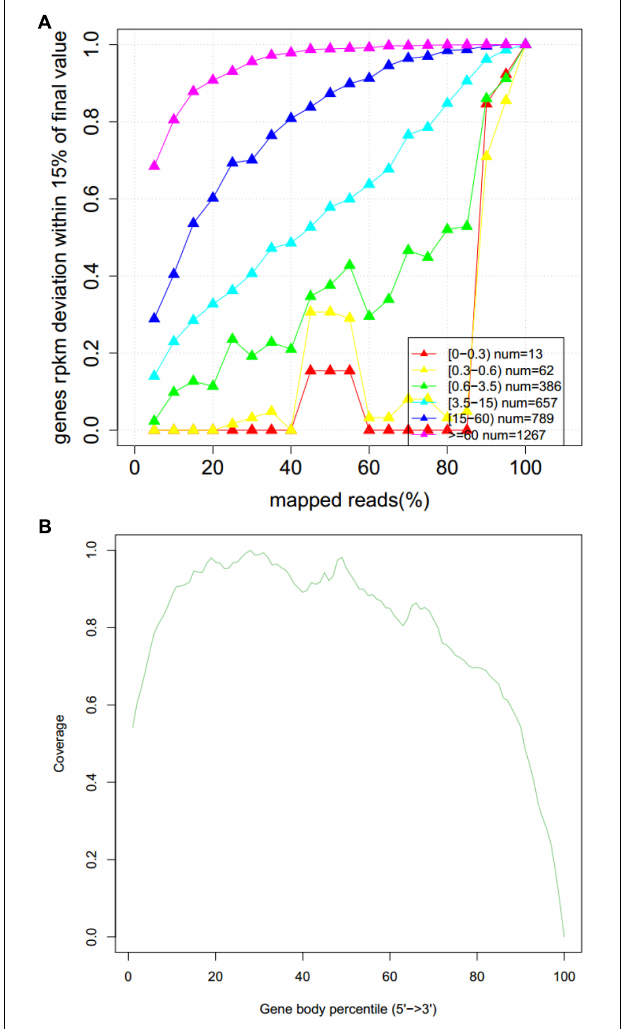
FIGURE 4 | The growth and ammonium nitrogen removal by strain YT03. Error bars mean ± SD of three replicates. FIGURE 5 | Sequencing saturation curve (A) and gene coverage analysis (B)